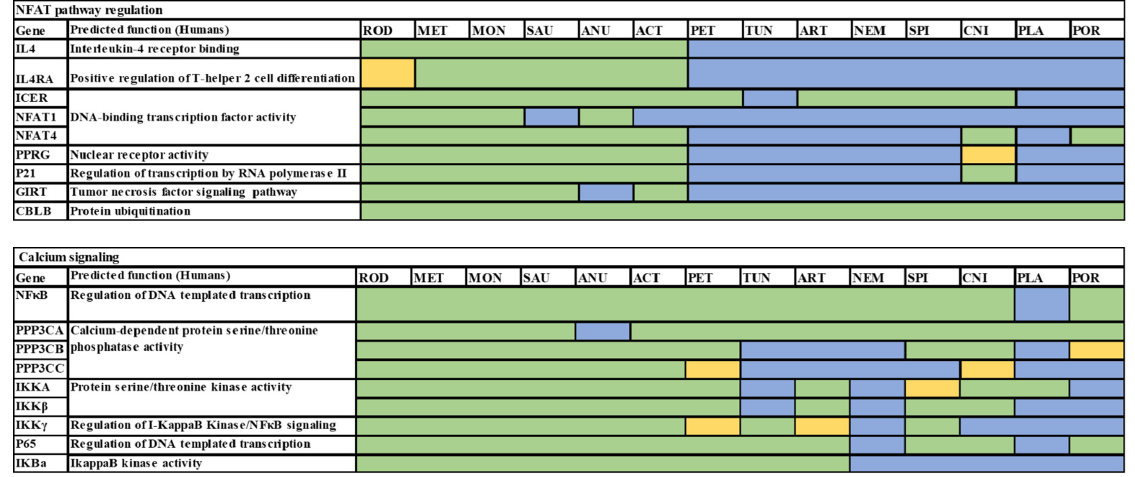
Figure 2 . Evolutionary history of Treg-mediated suppression pathways. ( A ) Phylogenetic analysis of Treg pathway (homology based). Each family identified in Table 1 is shown with a different color code. ( B ) Non-homology analysis. Non-homology-based analysis does not assume that homology is the basis of functional conservation. Proteins that have similar predicted functions to their human counterparts are shown in green, while those predicted to perform alternative functions are depicted in orange. Proteins that were deemed to be missing from a given proteome are shown in light blue. The following abbreviations are used: Rodentia (ROD), Monotremata (MON), Metatheria (MET), Sauria (SAU), Actinopterygii (ACT), Anura Salientia (ANU), Petromyzontiformes (PET), Tunicata (TUN), Arthropoda (ART), Nematoda (NEM), Spiralia (SPI), Cnidaria (CNI), Placozoa (PLA), and Porifera (POR). Overall, there is agreement between phylogenetic-based prediction and functional prediction using artificial intelligence/machine learning methods. Although Treg cells seem to have first appeared in jawed vertebrates, they employed various more ancient pathways. For example, TGFβ1, NFAT, NFκB first appeared in Porifera. Various suppression pathway components appeared in lampreys, including the PPP3C family, as well as TGFβ.